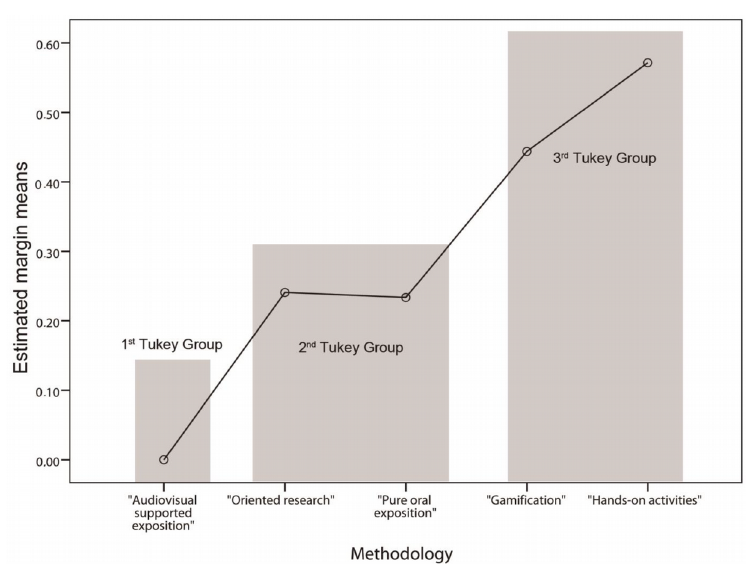
Figure 3. Estimated marginal means for Dynamic Emotions vs Teaching